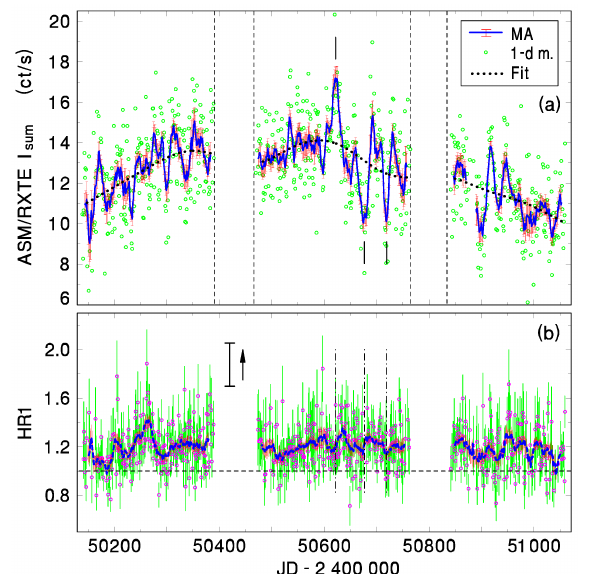
Figure 1: (a) X-ray light curve of KS 1731–260 during the main outburst. MA of I sum ( Q = 5 d) enhance the visibility of the modulation. The smooth curve shows the main trend (the HEC13 fit). The time interval around the conjunction with the Sun is marked. (b) Time variation of HR 1. The smooth line represents MA for Q = 8 d. The errors of MA are the standard er- rors. The big error bar and arrow in panel b mark the influence of absorption. Three prominent extrema of I sum and their HR 1 are marked. See Sect. 3 for details.